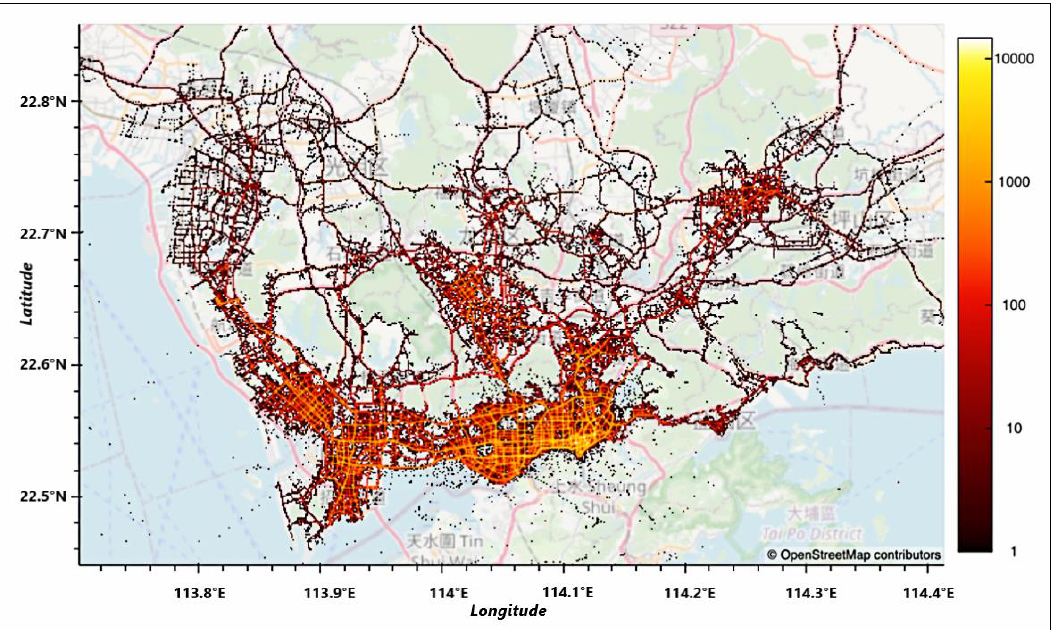
Figure 3. Heat map of the taxi trajectories (with passengers) in Shenzhen.